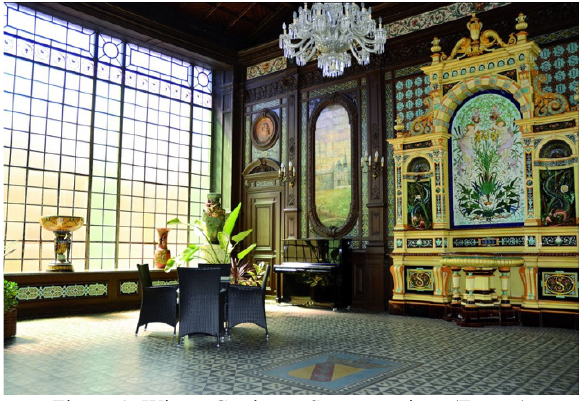
Figure 1. Winter Garden at Sarreguemines (France)